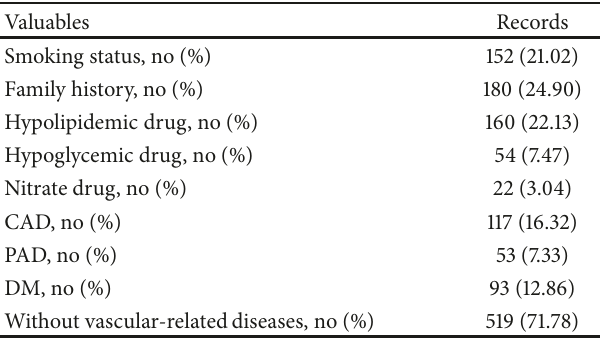
Table3:Historyofvascularrelateddiseasesandmedicationsintotal population.